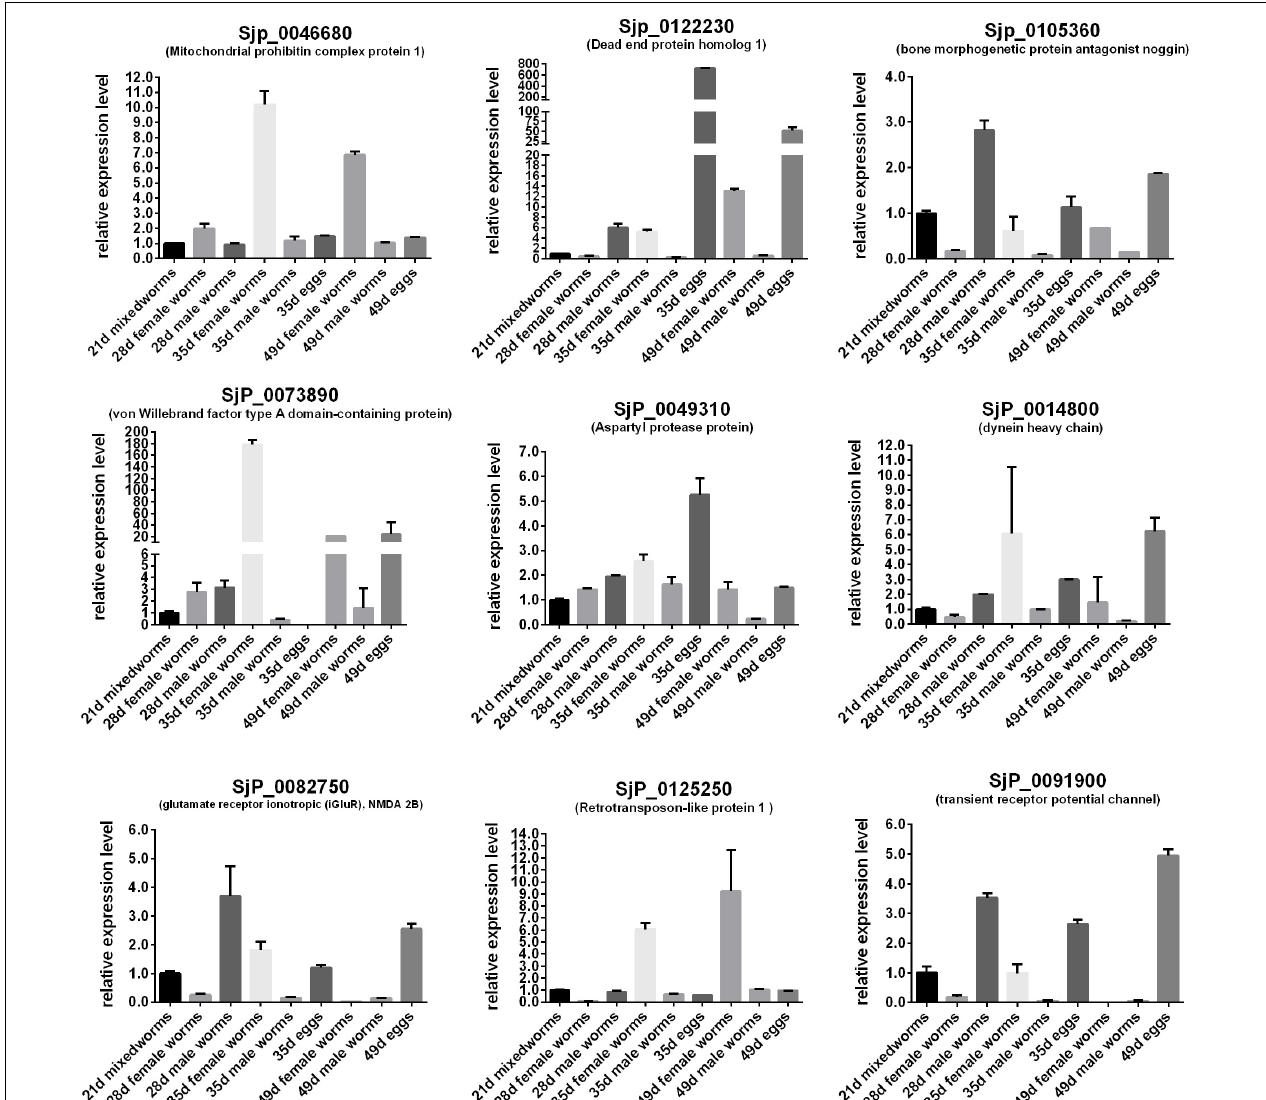
FIGURE 7 | Expression profiles of some differentially expressed genes of the worms with important biological significance in reproductive and embryonic development through their life stages in BALB/c mice.